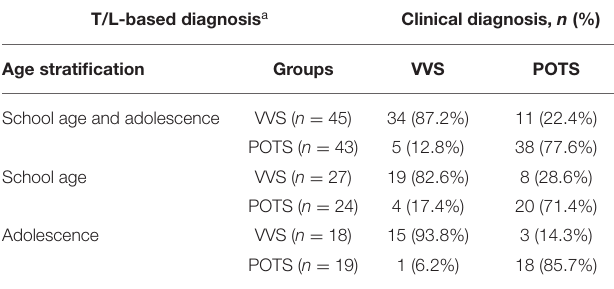
TABLE 5 | Validation of differential diagnostic performance of T/L in Poincaré plot in validation